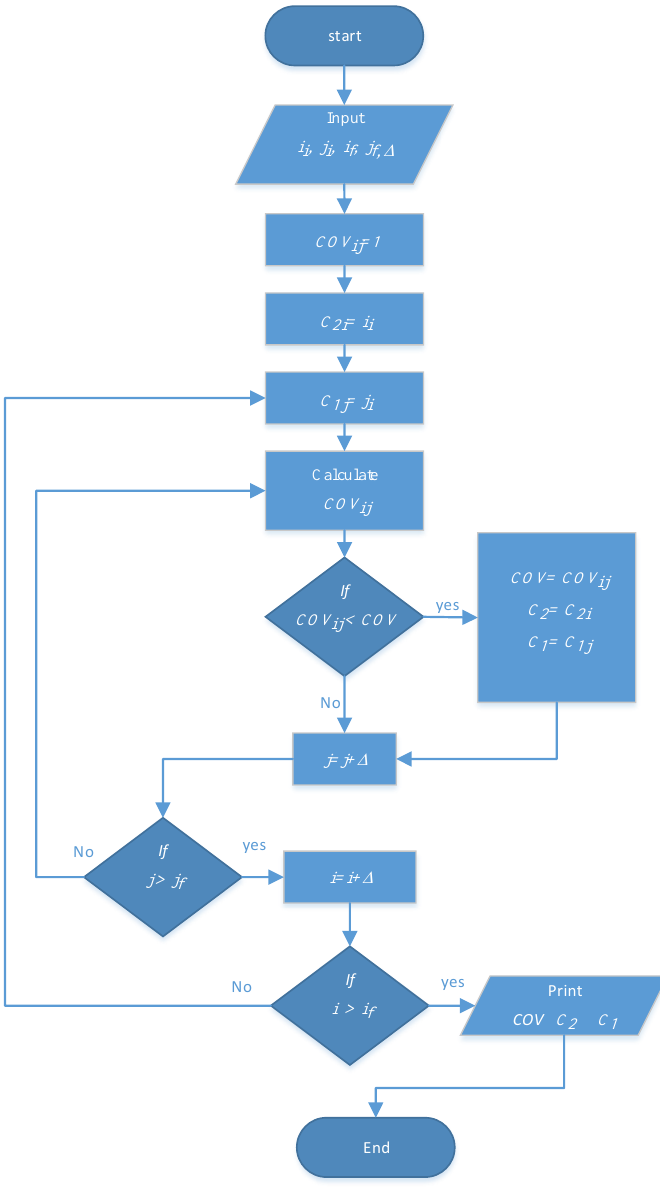
Figure 6. BS5400, EC4 and DBJ13-51 first proposal flowchart.